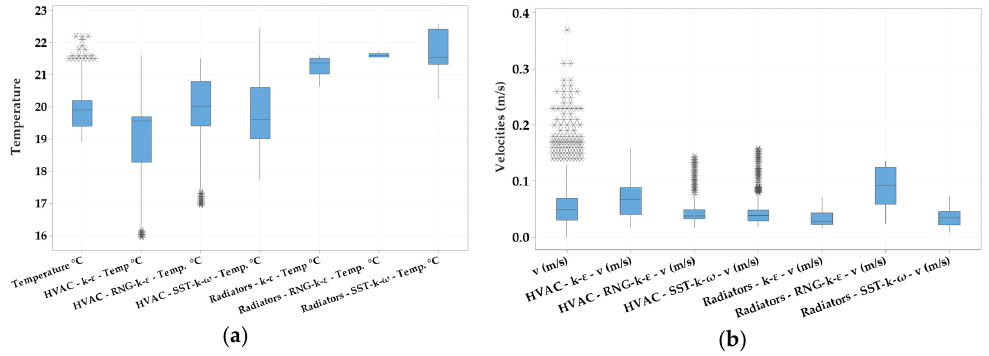
Figure 2. Boxplot of temperature ( a ) and air velocities ( b ) variation from indoor air quality sensors, static heaters and heating, ventilation and air conditioning (HVAC) system, for the three turbulence models (standard k- ε , SST-k- ω and RNG-k- ε ).